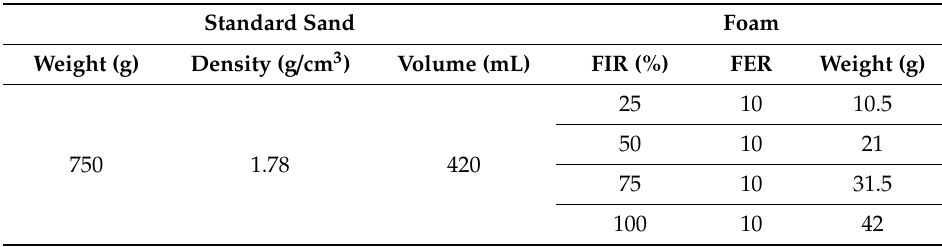
Figure 4. Standard sand average particle size gradation curve. Table 2. Weight at different foam injection ratios. Table 2. Weight at di ff erent foam injection ratios.